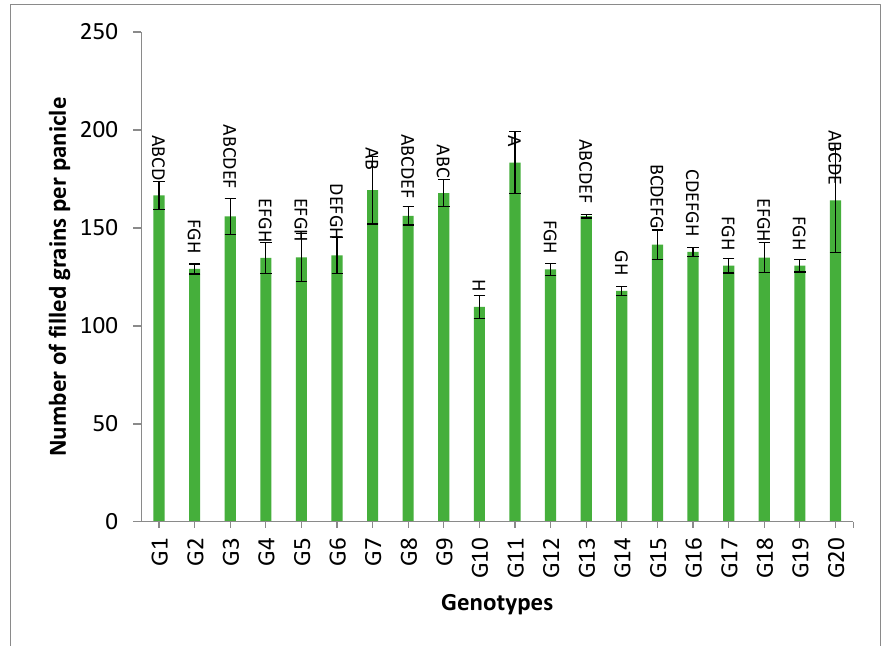
Figure 6. The mean numbers of filled grains per panicle of twenty rice genotypes over the two years. Bar represents the standard deviation.